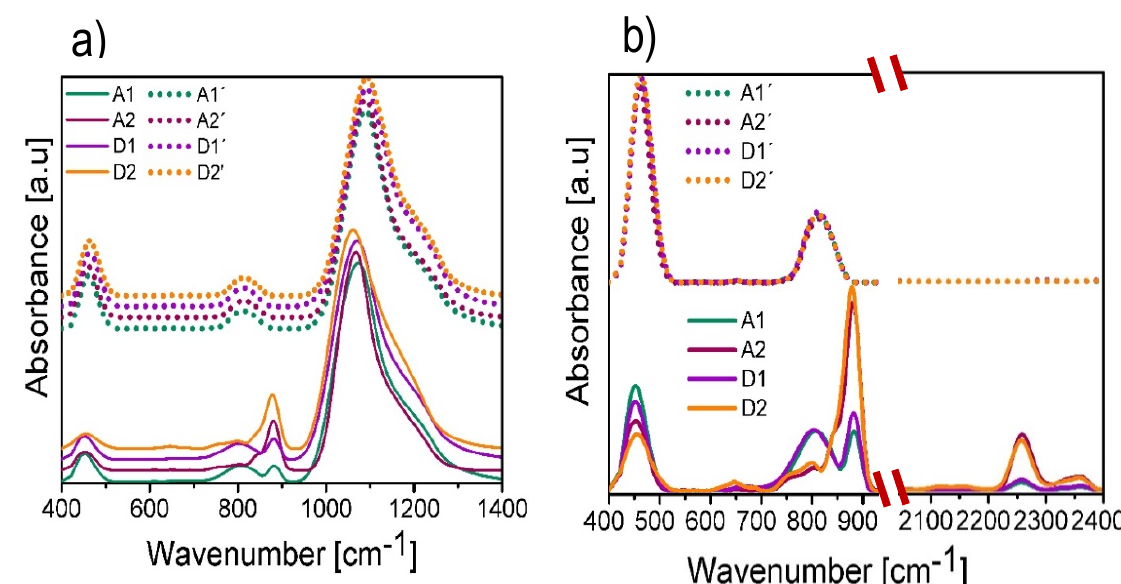
Figure 5. ( a ) The Fourier Transform Infrared (FTIR) spectra obtained for the SiO x films in a range from 400 cm − 1 to 1400 cm − 1 . ( b ) FTIR spectra obtained for SiO x films in a range from 400 cm − 1 to 950 cm − 1 and from 2150 cm − 1 to 2400 cm − 1 .